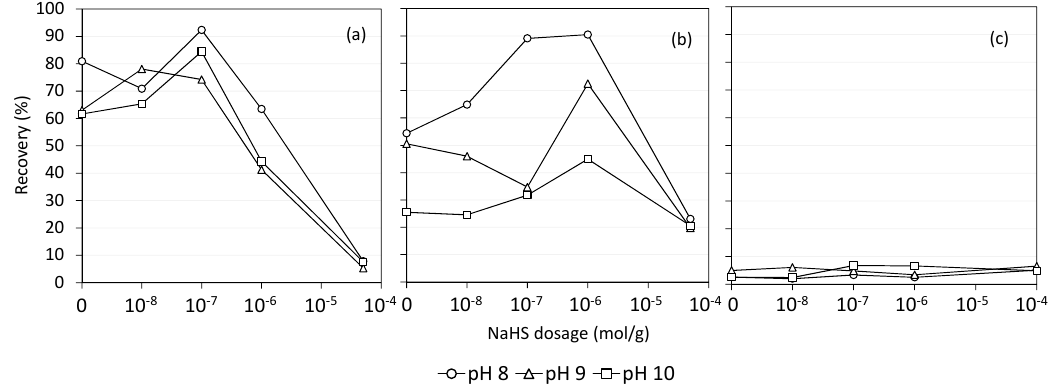
Figure 4. The recoveries of the minerals versus several NaHS dosages for ( a ) chalcocite, ( b ) bornite, and ( c ) chalcopyrite at pH 8, 9, and 10 with the small column cell (NaHS 0 M means only oxidation treatment was conducted.).